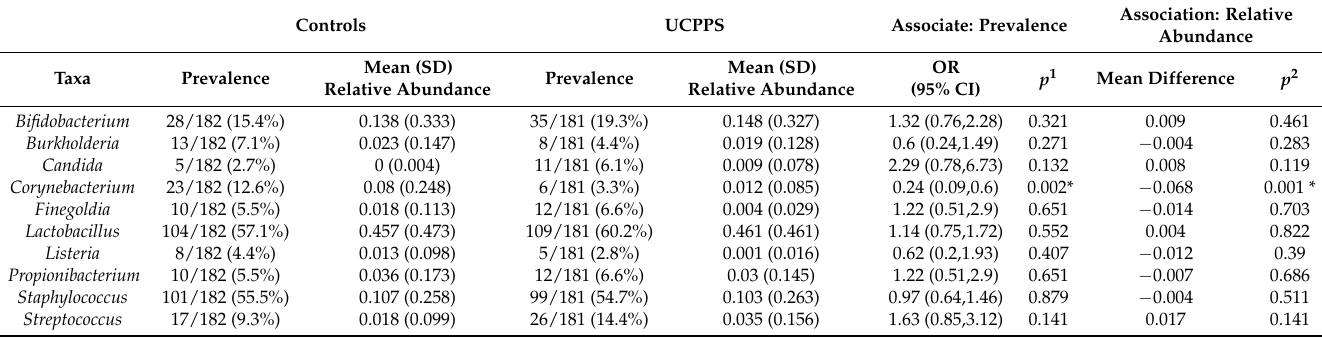
Table 6. Genus Level Differences in Prevalence and Relative Abundance for UCPPS participants compared to Controls. Controls UCPPS Associate: Prevalence